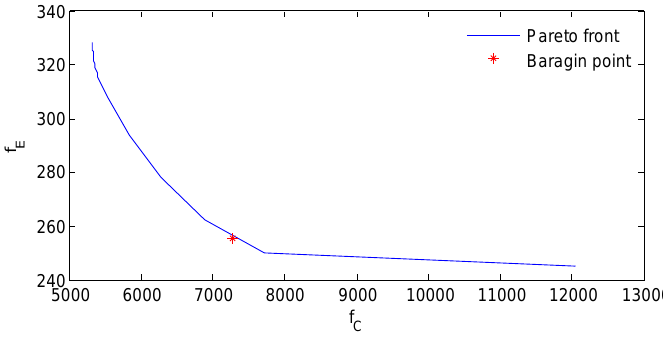
Figure 5. Pareto front and balancing solution for BOED(Equation (35)).